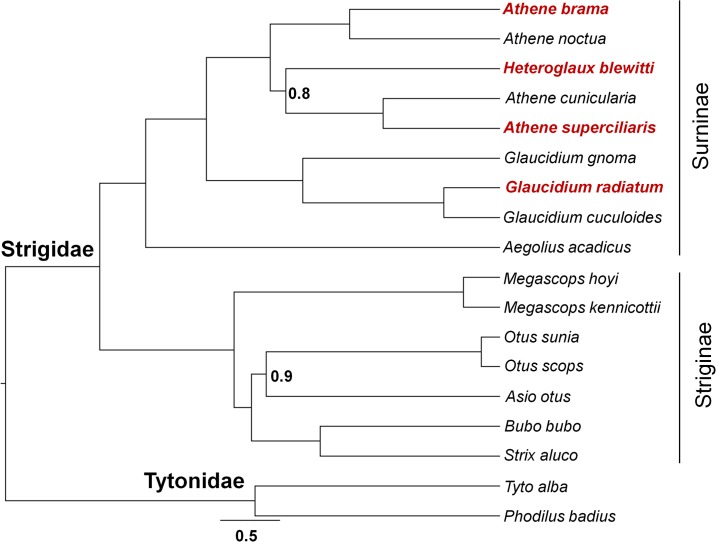
A species tree reconstruction using BEAST on concatenated (mitochondrial + nuclear) dataset indicate that H. blewitti is nested within the Athene clade.The brown text indicates the species sampled in the present study. The nodal values show Bayesian posterior probability (PP). All the nodes are highly supported (PP = 1) except for those where PP is mentioned as nodal value.